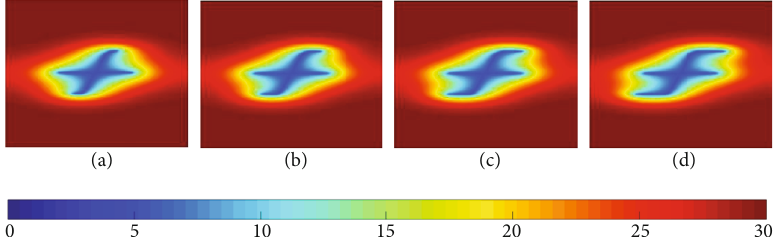
= 10m , (b) L = 30 m , (c) f 2 i f 2 i